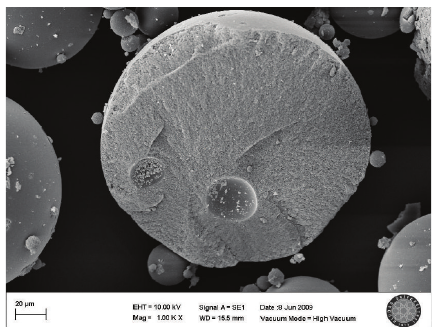
Figure 1: SEM micrographs of poly(EGDMA-VIM) beads.